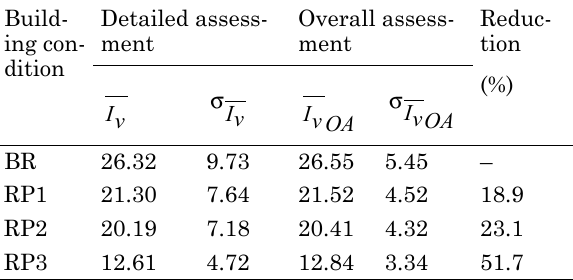
Table 4. Vulnerability index values and reduction values